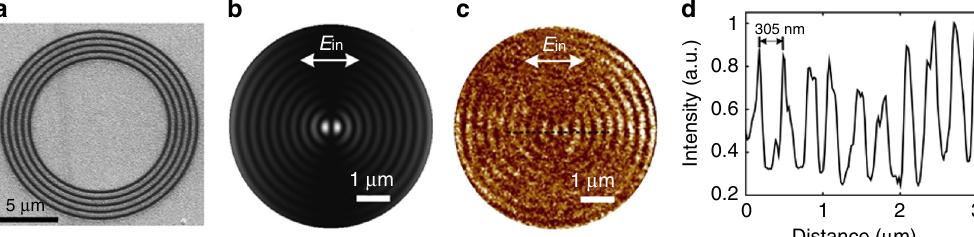
Fig. 3 Characterization of a subwavelength SPPs focus in a Sb 2 Te 3 thin fi lm. a SEM image of the fabricated ultrathin plasmonic lens. b Simulated intensity distribution of the plasmonic focus excited by the plasmonic lens. The arrow shows the orientation of linearly polarized incident light. c Experimentally measured intensity distribution of the plasmonic focus by a SNOM system. d The cross-section of the measured intensity distribution of the plasmonic focus. The wavelength of the incident light beam is 640 nm. The period of the interference fringes of evanescent SPPs standing waves is around 305 nm which suggests the SPPs wavelength of 610 nm in the